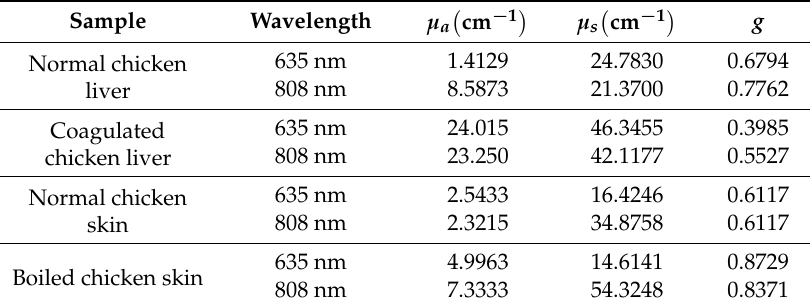
Table 1. The calculated optical parameters.